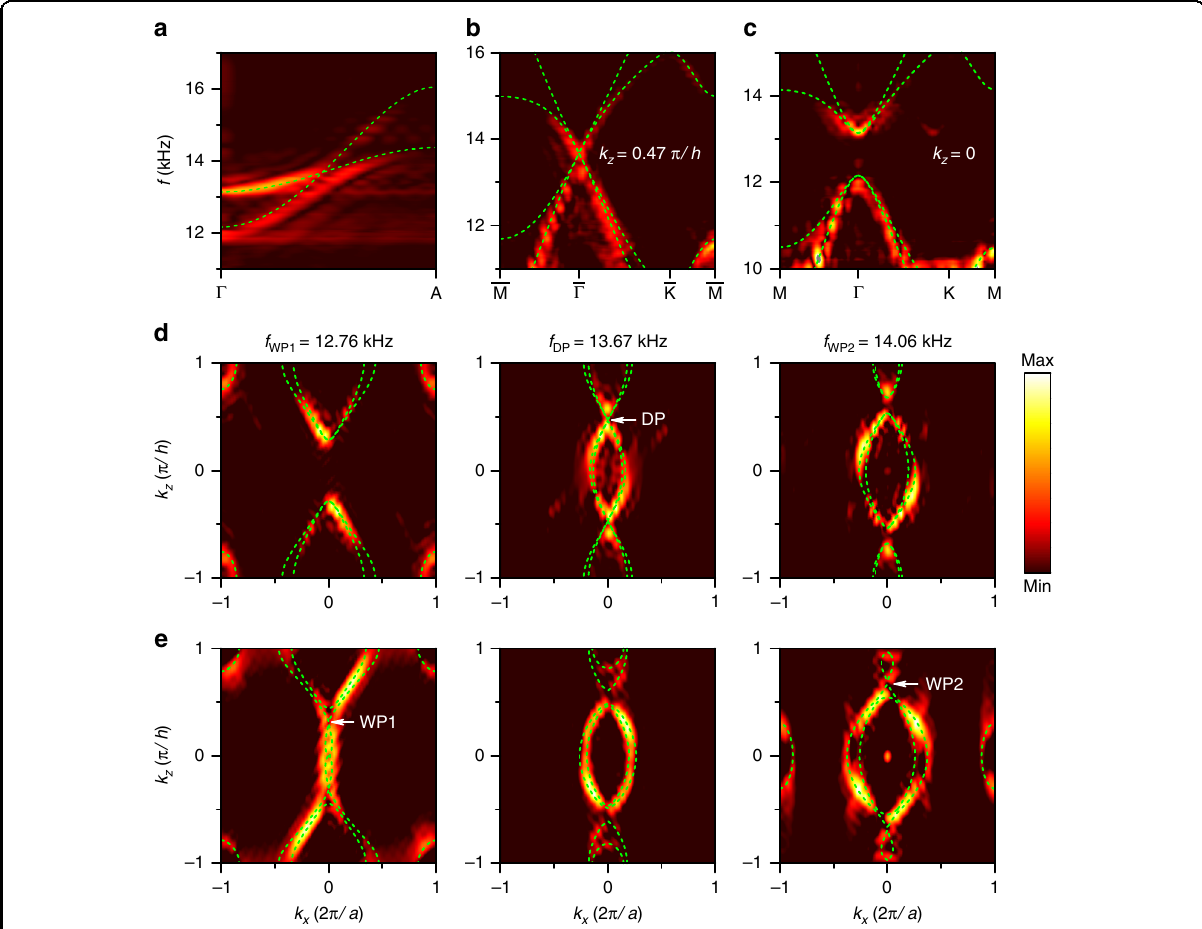
Fig. 2 Experimentally mapped bulk band structure. a Band dispersion along the Γ A direction. b , c Band dispersion in the reduced 2D planes at k z ¼ 0 : 47 π = h and k z ¼ 0. d , e Equifrequency contours with k y ¼ 0 for d the 3D Dirac sonic crystal and e the Weyl sonic crystal at frequencies of 12.76kHz (WP1), 13.67 kHz (DP) and 14.06 kHz (WP2). The colour maps represent the strength of the states probed in the sonic crystal. The green dashed lines represent the calculated values obtained from full-wave